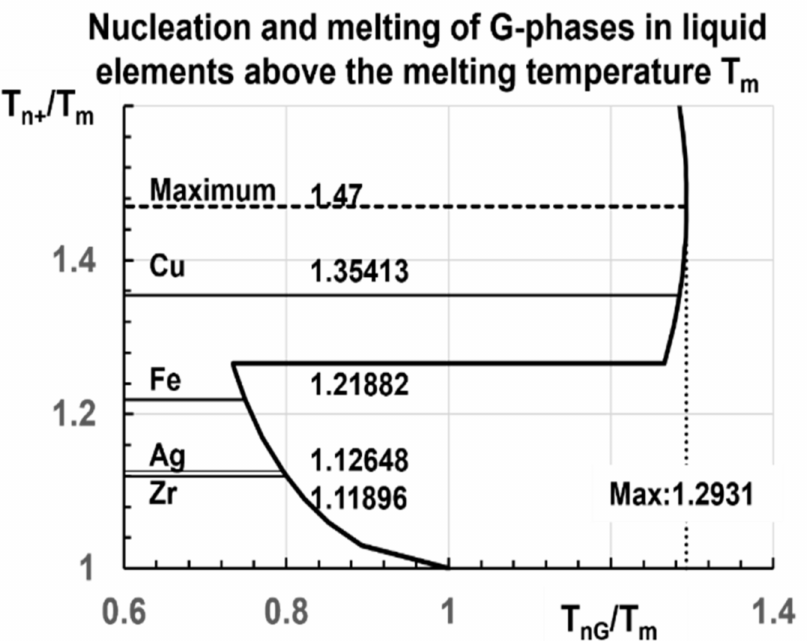
Figure 5. Universal diagram of T n+ /T m versus T nG /T m of all liquid elements with higher and higher heating rates. The ratios T n+ /T m = 1.11896 for Zr (T n+ = 2378 K, T m = 2125 K) [79], 1.12648 for Ag (T n+ = 1391 K, T m = 1234.9 K) [45], 1.21882 for Fe (T n+ = 2207 K, T m = 1811 K) [78], and 1.35413 for Cu (T n+ = 1839 K, T m = 1358 K) [78] had been already observed by MD simulations at various high heating rates as shown in Figures 5–7.